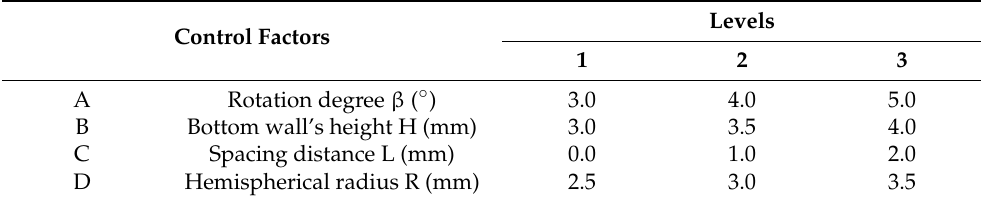
Table 2. Control factors and level settings